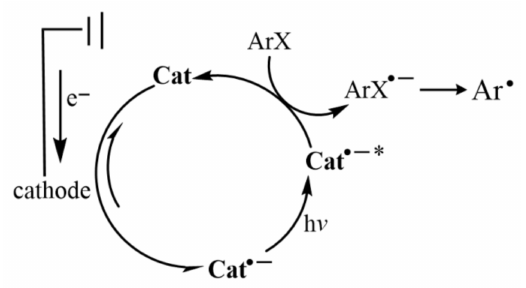
Figure 14. Proposed catalytic cycle of electro-photo-catalytically generated aryl radicals. Reprinted with permission from Ref. [56]. Copyright 2020, American Chemical